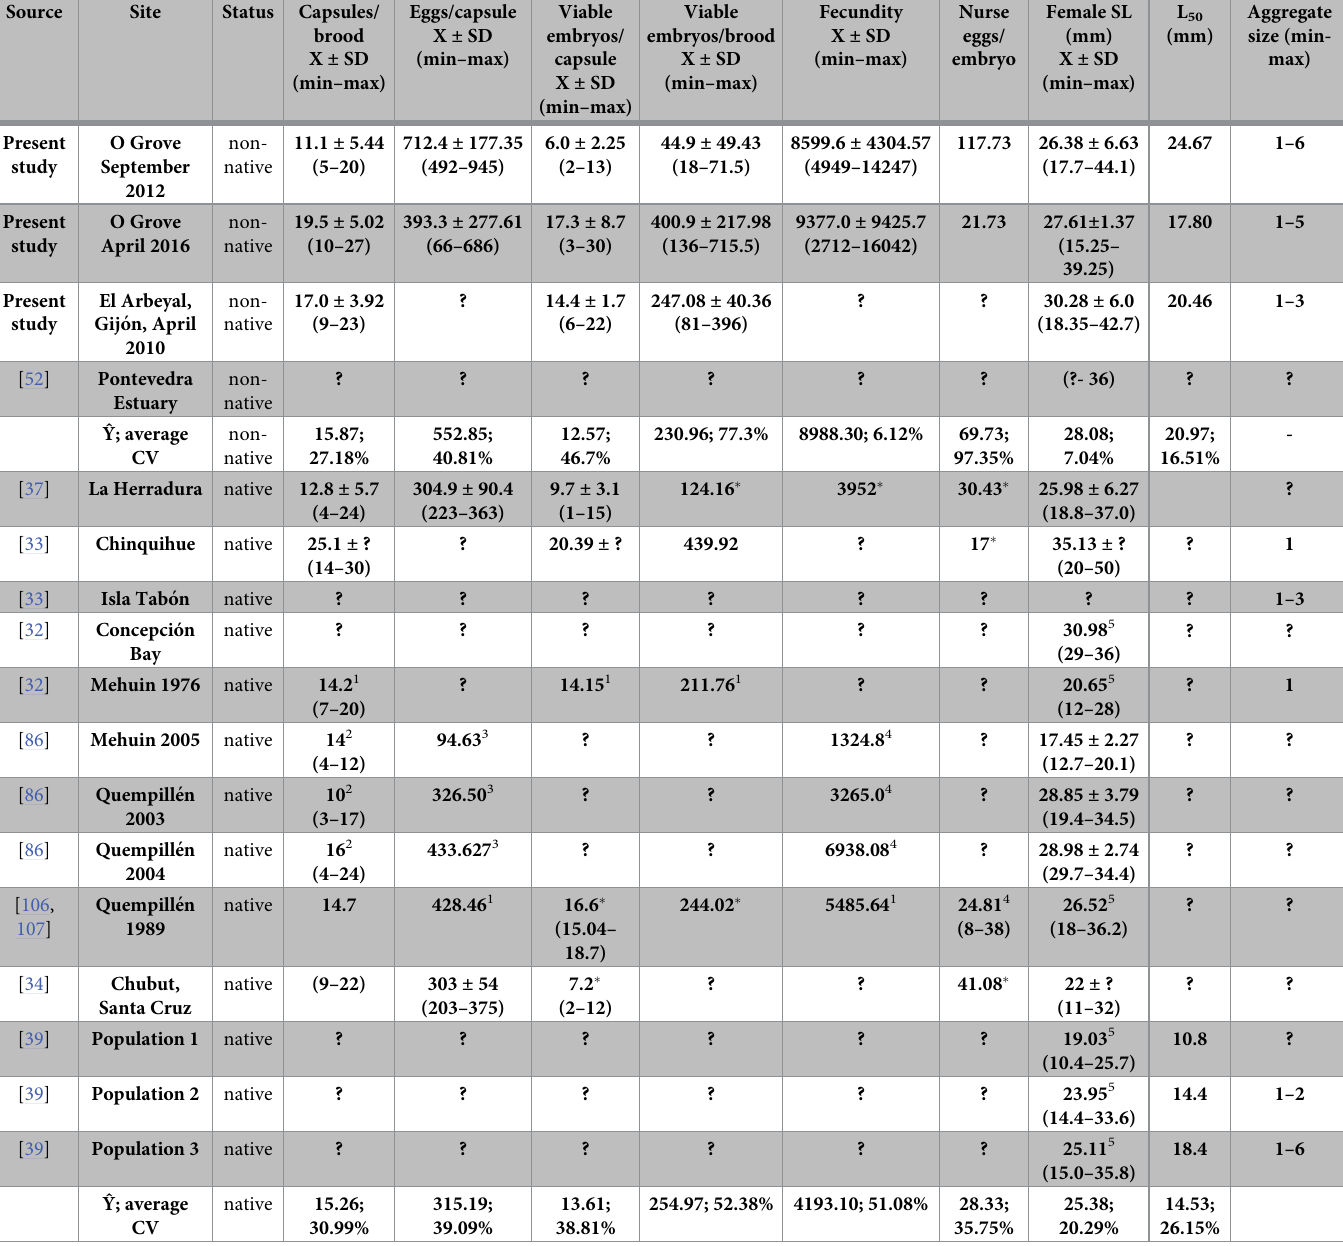
Table 7. Reproductive traits of Crepipatella dilatata across its current distribution range.